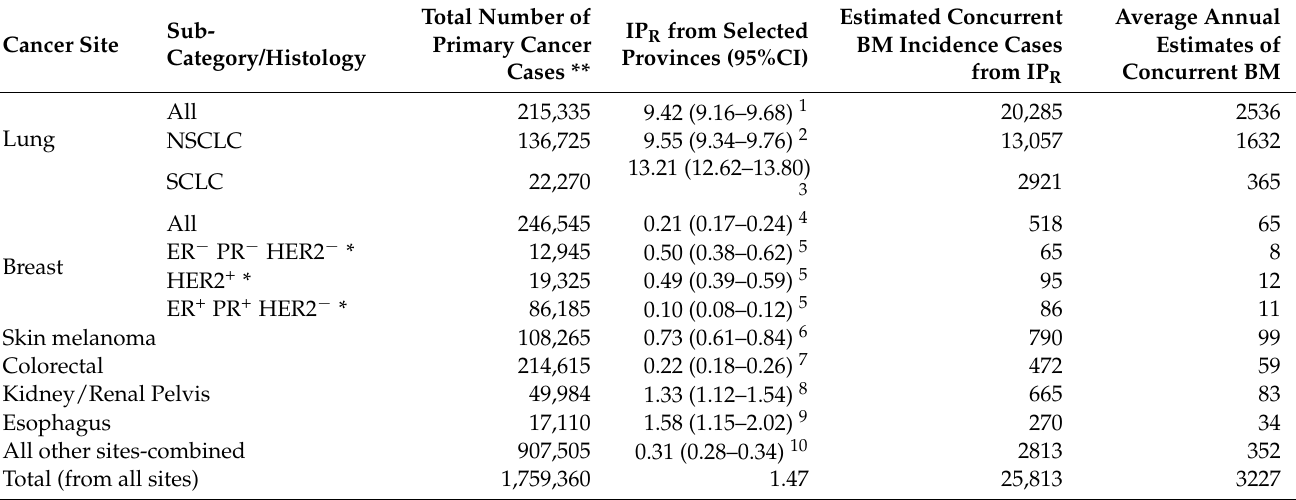
Table 3. Estimated refined concurrent incidence proportion (IP R ) and frequency of BM in Canada by selected cancer sites adjusting for missing data